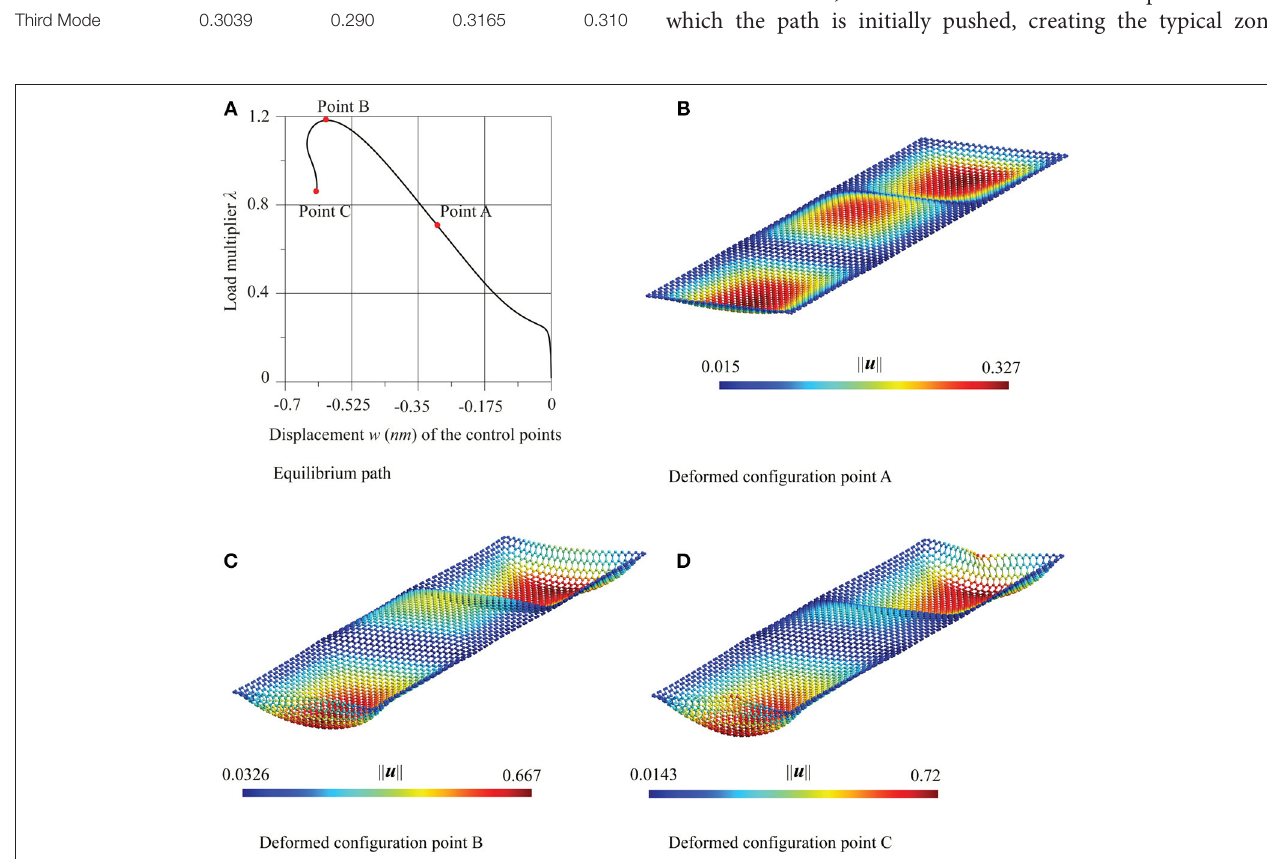
FIGURE 10 | Supported graphene strips under compression in the zigzag direction: (A) equilibrium path and (B–D) deformed configurations at the points A , B , and C .